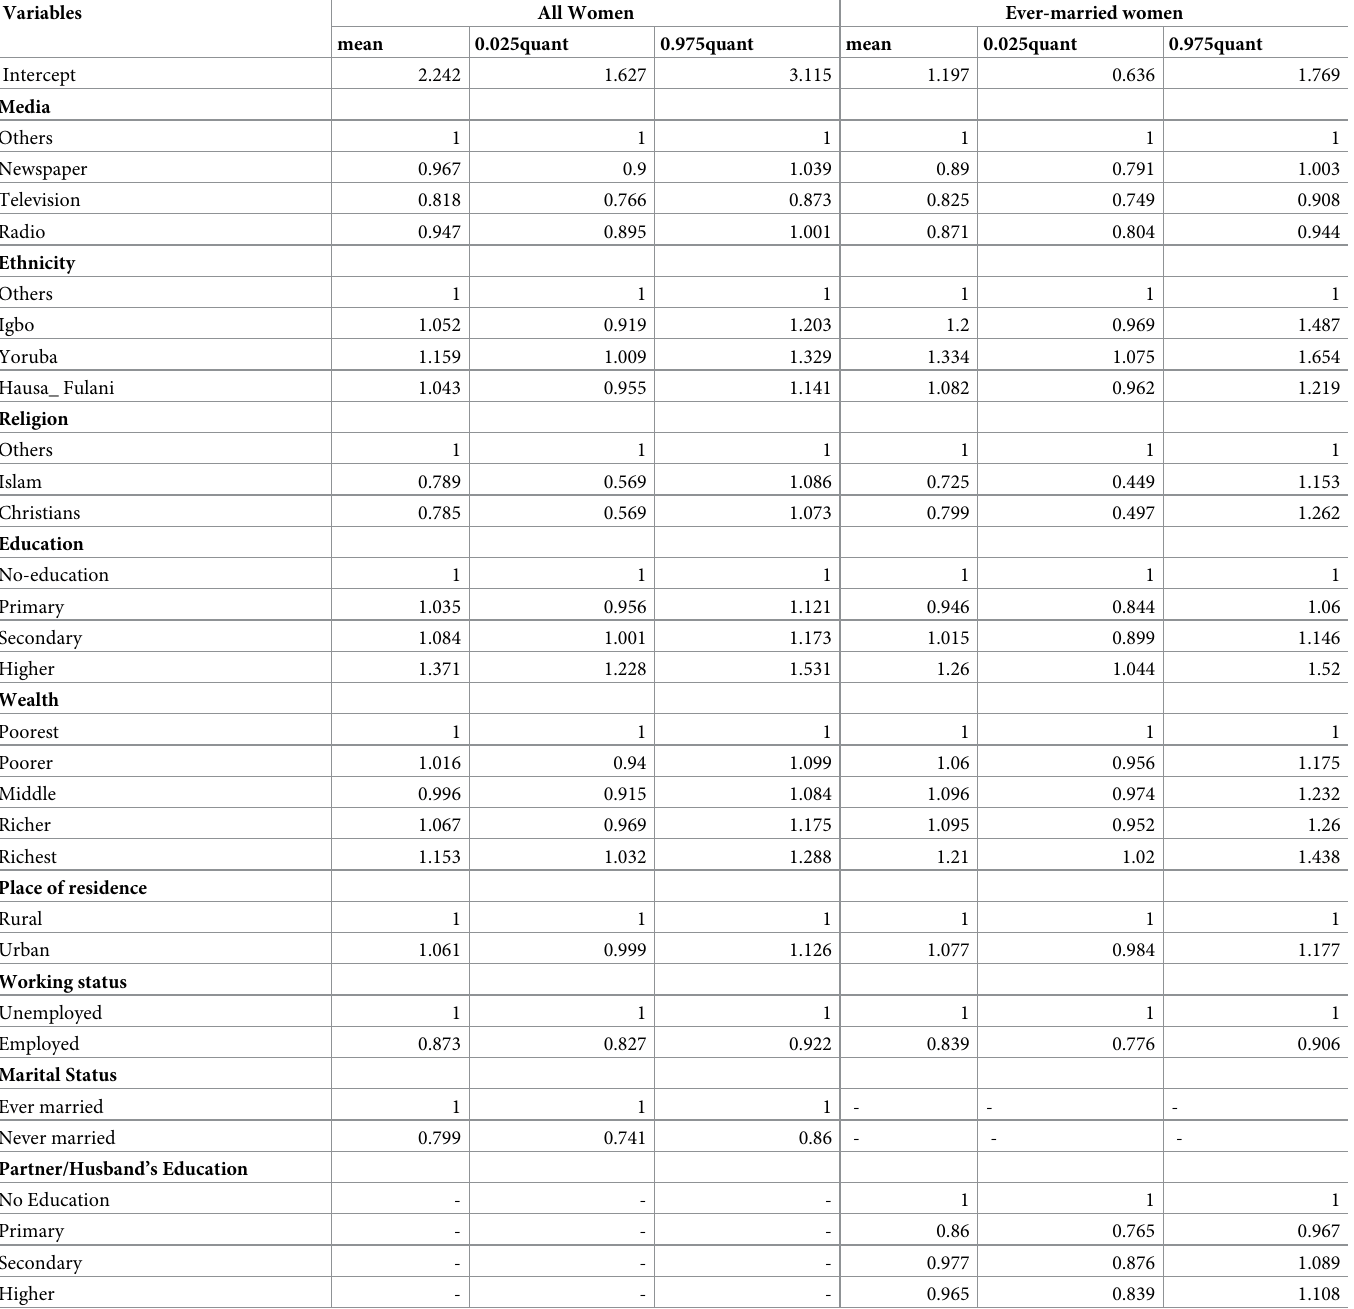
Table 4. Posterior odds ratio for the linear parameters of socio-economic and demographic